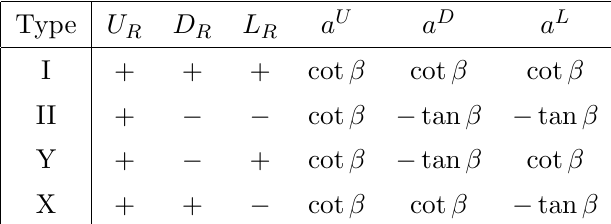
Table 1 . Di(cid:11)erent Z 2 symmetries that can be imposed on the 2HDM. (cid:8) 1 is odd( (cid:0) 1) and (cid:8) 2 is even(+1). For every type of Z 2 symmetry, the (cid:26) F matrices become proportional to the diagonal mass matrices, (cid:26) F = a F (cid:20) F